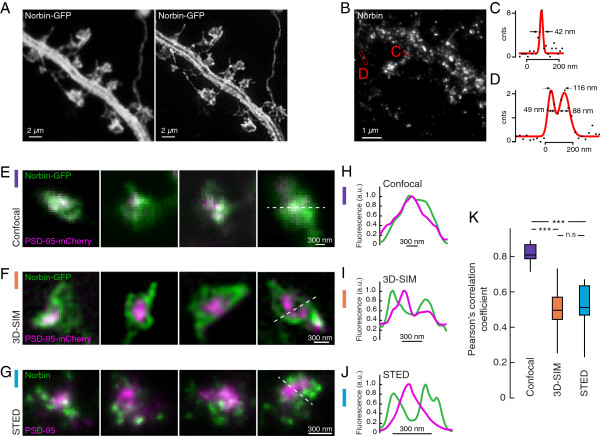
Super-resolution reveals that Norbin does not colocalize with PSD-95. A) Confocal (left) and 3D-SIM image of Norbin-GFP distribution in a dendrite with spines. B) STED image of immunolabeled Norbin in dendrite and spines. C) Line profiles taken from B) (dots) fitted with a Gaussian function (red) indicate a resolution of ~40 nm in the Norbin channel. In D) two emitters 116 nm apart have been clearly separated. For the profiles, a patch was taken from the image as indicated in B) and integrated along the shorter edge. E) Confocal recordings of Norbin-GFP and PSD-95-mCherry show a complete colocalization in spines. F) Using 3D-SIM, the distributions of Norbin-GFP and PSD-95-mCherry are resolved. G) Immunolabeled endogenous Norbin and PSD-95 recorded using stimulated emission depletion (STED) show the same overall distribution as 3D-SIM images of exogenous expressed Norbin and PSD-95. H-J) Intensity profiles along the dashed lines over spine heads in A-C illustrate that confocal microscopy does not have the resolving power of 3D-SIM and STED to identify the discrete localizations of Norbin (green) and PSD-95 (magenta). K) Norbin is non-uniformly distributed in spines and has a low degree of colocalization with PSD-95, reflected in a median Pearson’s correlation coefficient (PCC) of 0.49 (n = 27) for 3D-SIM and 0.50 (n = 17) for STED. Compared to the 3D-SIM and STED PCCs, the confocal recordings gave a significantly higher median PCC of 0.81 (n = 15) (***p < 0.00001, Kruskal-Wallis test). The PCCs between the 3D-SIM and STED images are not different (n.s p > 0.5, Kruskal-Wallis test). n = number of analyzed spines.